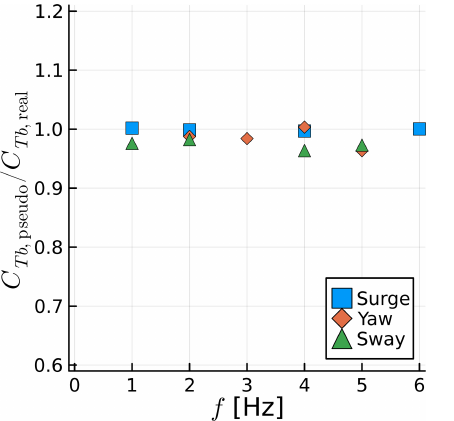
Figure 24. Amplitude of blade thrust coefficient fluctuation for var- ious maximum tip yaw velocities. Simulations results are shown, along with the theoretical possible range of results as dashed lines.